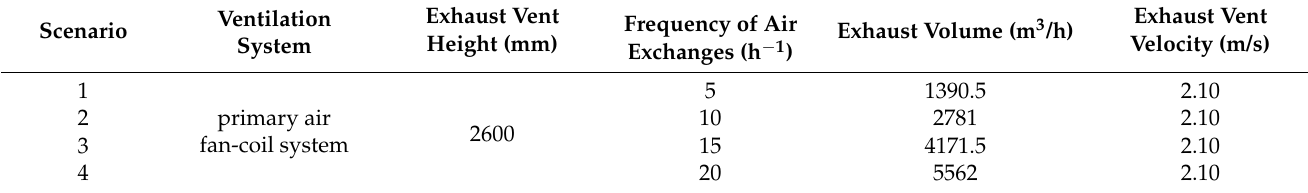
Table 6. Boundary conditions for the frequency of air